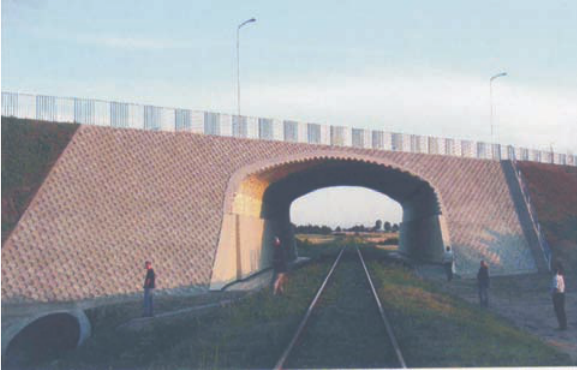
fig. 2. Side view on the road viaduct made from steel corrugated plates situated over railway line in Prudnik, Poland